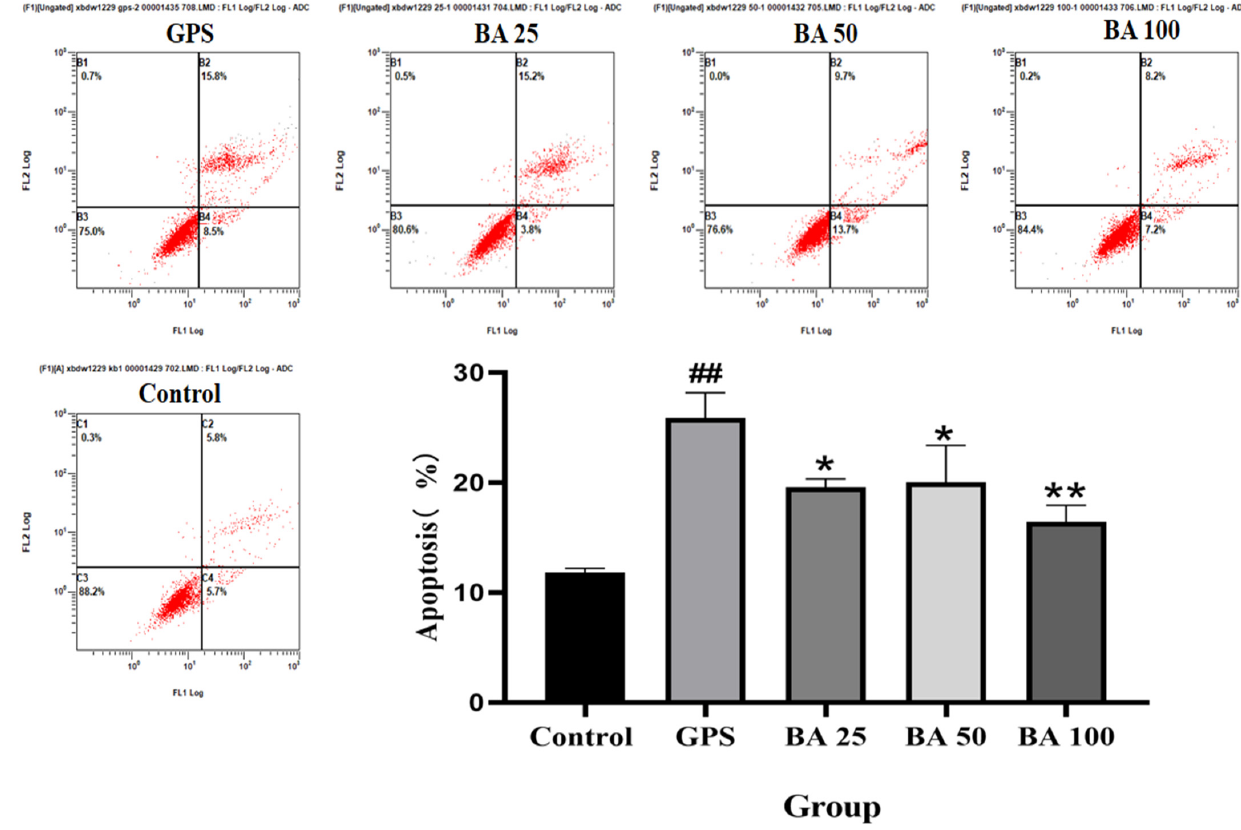
Figure 1. Effects of baicalin on GPS induced apoptosis in PPMC (Mean ± SD, n = 3). GPS: G. parasuis group, BA 25: 25 mg/kg baicalin + G. parasuis group, BA 50: 50 mg/kg baicalin + G. parasuis group, BA 100: 100 mg/kg baicalin + G. parasuis group. ## p < 0.01 vs control. * p < 0.05 vs G. parasuis group, and ** p < 0.01 vs G. parasuis group.